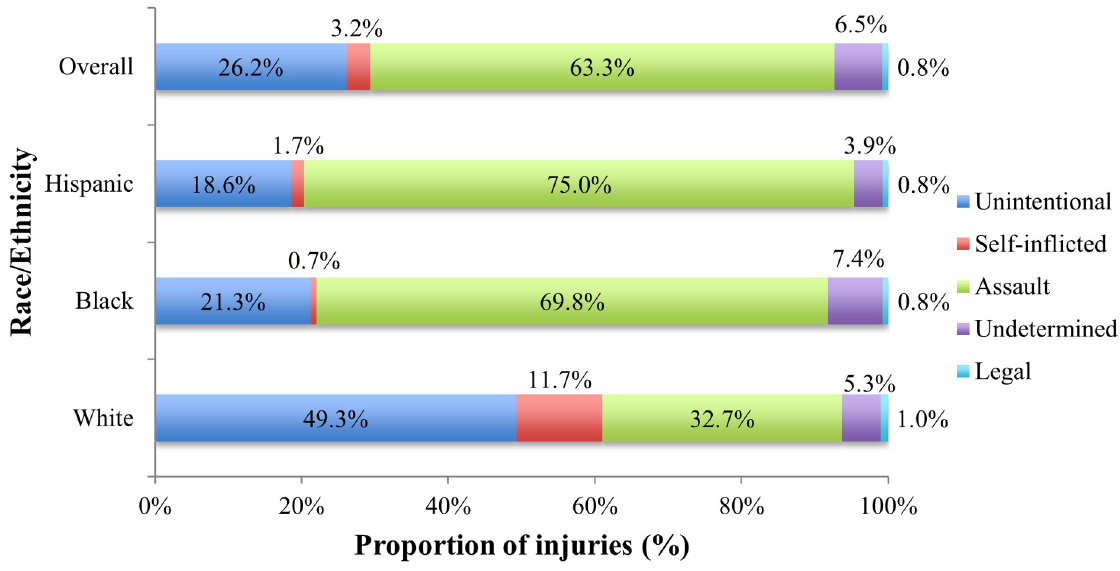
Fig 3. Intent of pediatric firearm-related injuries by